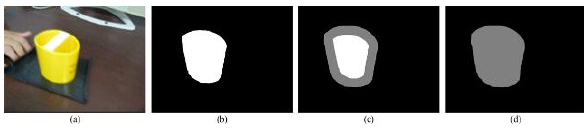
Figure 3. (a) The yellow brush pot as an instance of OOI, (b) OOI mask, (c) The trimap of the graph cuts-based method, white, gray, and black indicate foreground, the unlabelled and background respectively, and (d) The dual map of the proposed